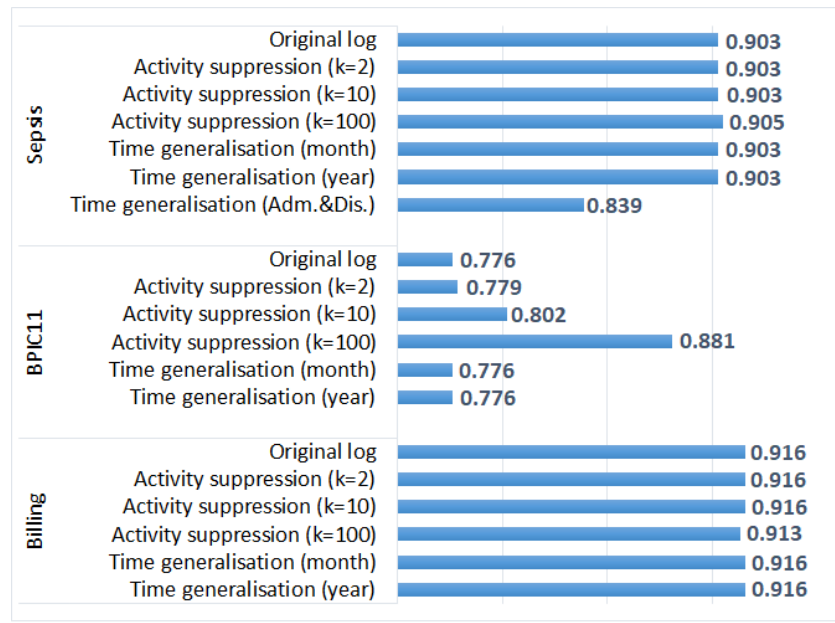
Figure 5. The impact of activity suppression and time generalisation on the results of process conformance analysis: the average trace fitness values for the three event